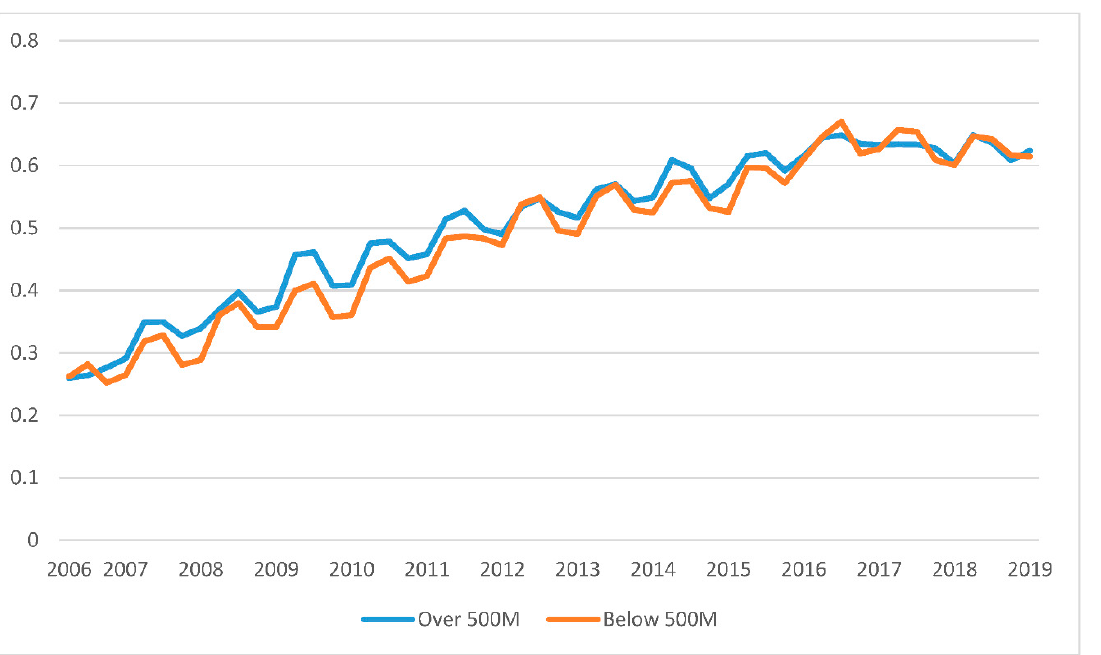
Figure A7. Average recycling rate for local authorities that have had more/less than 500 million pounds spent in by all overnight travellers from 2011 to 2019. Source: WasteDataFlow and the Tourism Profile.